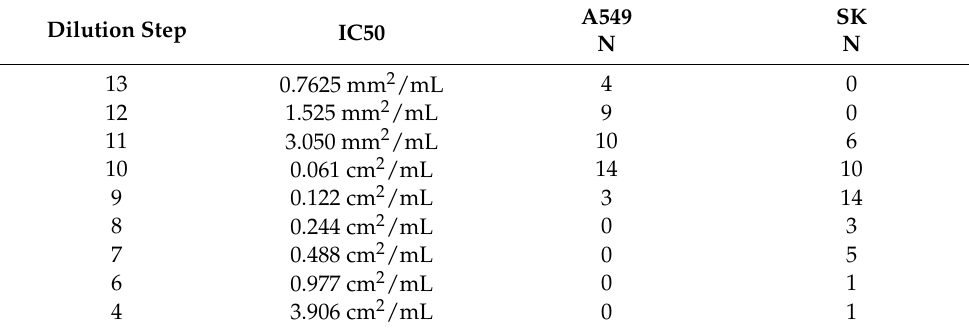
Table 3. Distribution of threshold toxicity level (IC50) of Aspergillus section Fumigati isolates. Dilution Step